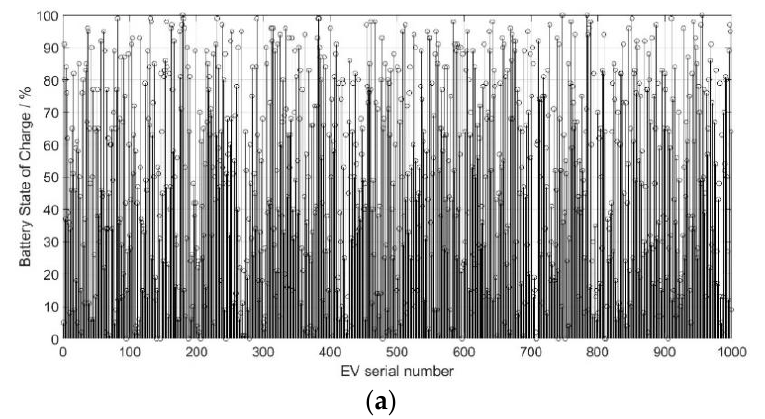
Figure 8. Charging power of EV i,j in the group of: ( a ) SoCi.class = 1,AVDTi.class = 1; ( b ) SoCi.class